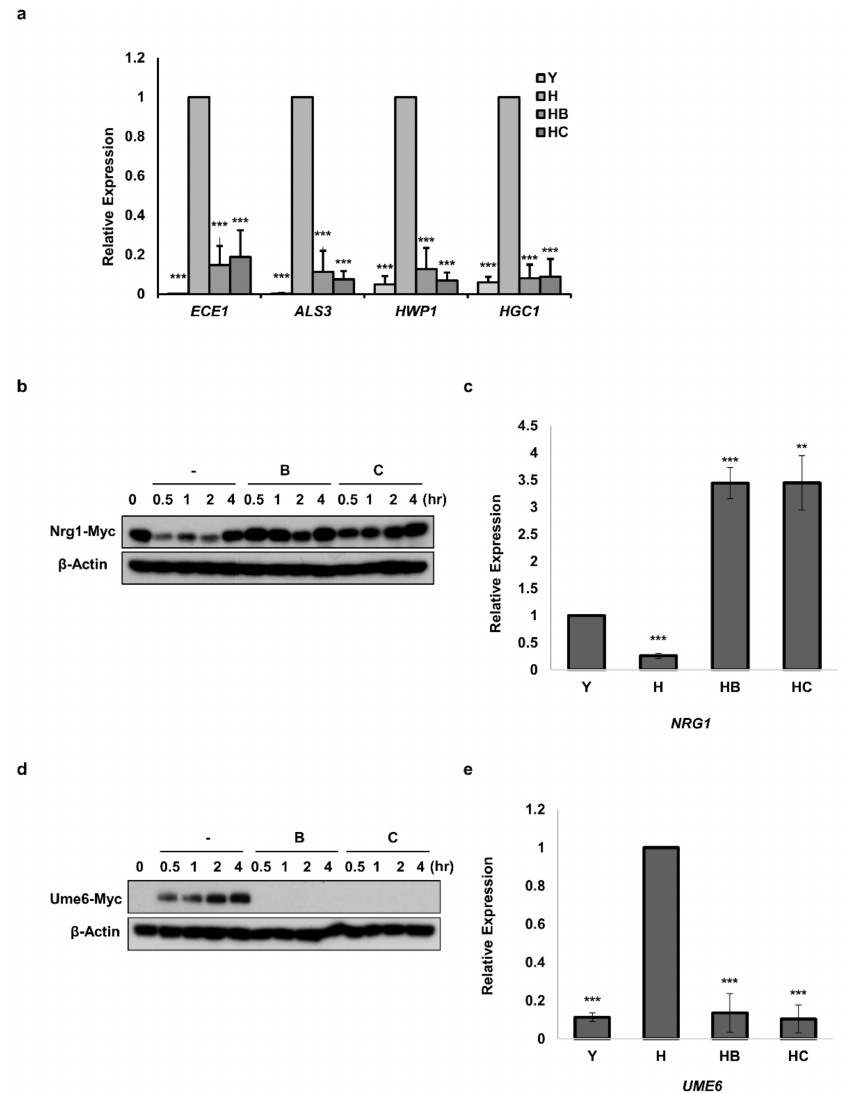
Figure 4. Effects of Molecule B and Molecule C on the expression of HSG, Ume6, and Nrg1 genes. ( a ) Realtime PCR for comparison of HSGs expression 2 h after hyphae induction. Used strain: BWP17. Y, yeast cells; H, hyphae induced cells; HB, hyphae induced cells with Molecule B treatment (8 µ g/mL); HC, hyphae induced cells with Molecule C treatment (16 µ g/mL). ( b ) Changes in the protein levels of Nrg1 after inducing hyphal formation (0–4 h). Used strain: Nrg1-myc. B, hyphae induced cells with Molecule B treatment of 8 µ g/mL; C, hyphae induced cells with Molecule C treatment of 16 µ g/mL. ( c ) Realtime PCR for comparison of NRG1 expression 2 h after hyphae induction. Used strain: Nrg1-myc. Y, yeast cells; H, hyphae induced cells; HB, hyphae induced cells with Molecule B treatment (8 µ g/mL); HC, hyphae induced cells with Molecule C treatment (16 µ g/mL). ( d ) Changes in protein levels of Ume6 after inducing hyphal formation (0–4 h). Used strain: Ume6-myc. B, hyphae induced cells with Molecule B treatment (8 µ g/mL); C, hyphae induced cells with Molecule C treatment (16 µ g/mL). ( e ) Realtime PCR for the comparison of UME6 expression 2 h after hyphal formation induction. Used strain: Ume6-myc. Y, yeast cell; H, hyphae induced cells; HB, hyphae induced cells with Molecule B treatment (8 µ g/mL); HC, hyphae induced cells with Molecule C treatment (16 µ g/mL). Western blotting was performed with an anti-myc antibody to detect Nrg1-myc and Ume6-myc. In western blotting, β -actin was used as a loading control by detection using the anti- β -actin antibody. Each experiment was conducted in triplicate. The data represent the mean and standard deviation of three independent experiments. ** p < 0.01, *** p < 0.001 ( t